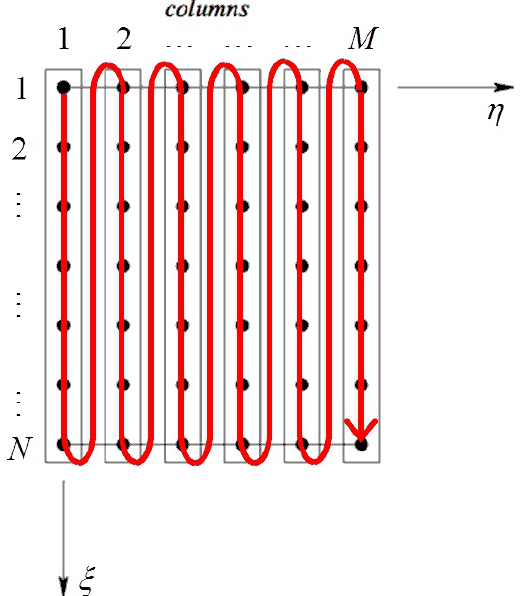
Figure 1: Grid point orders for DQ computation: the column order (boxes) and the corresponding vector